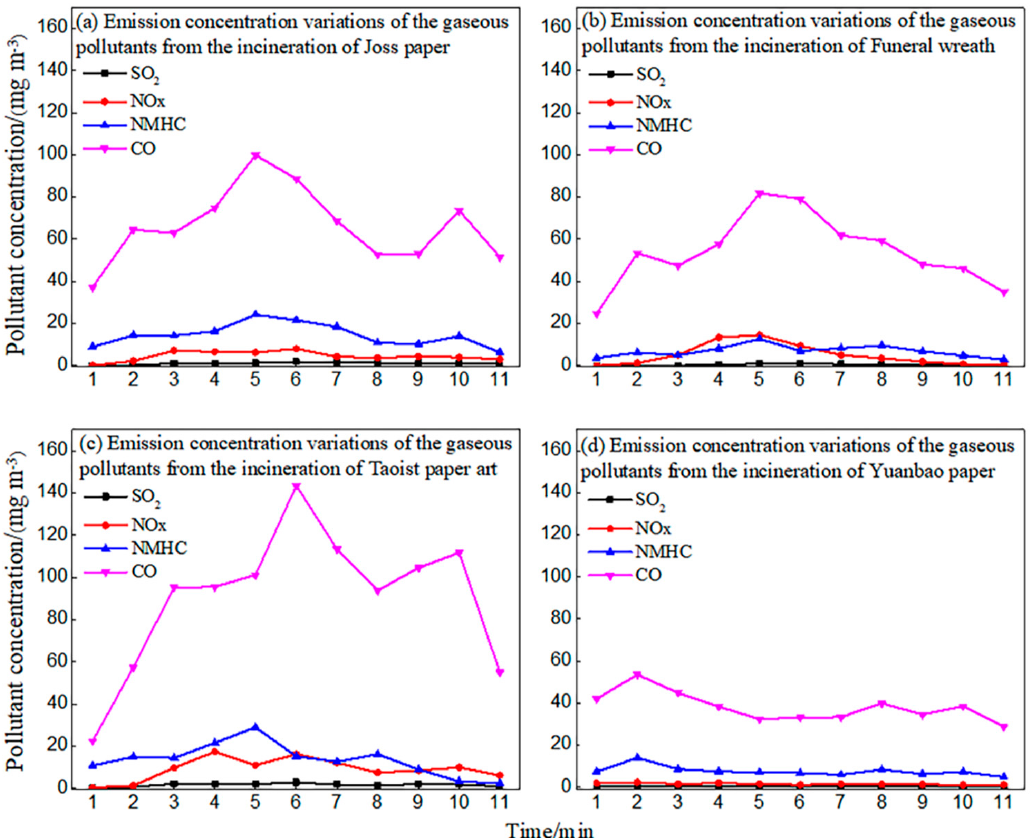
Figure 4. Emission concentration variations of the gaseous pollutants from the incineration of the four sacrificial offerings: ( a ) Joss paper; ( b ) Funeral wreath; ( c ) Taoist paper art; (d) Yuanbao paper.